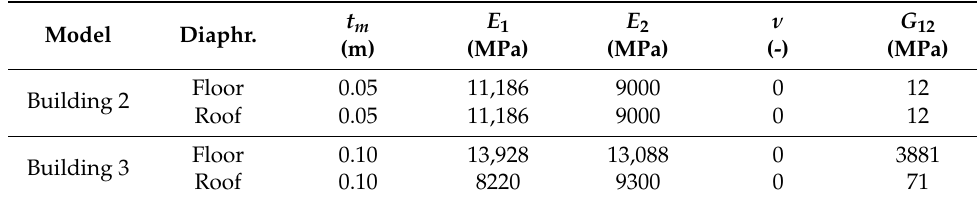
Table 6. Floor and roof diaphragm properties.